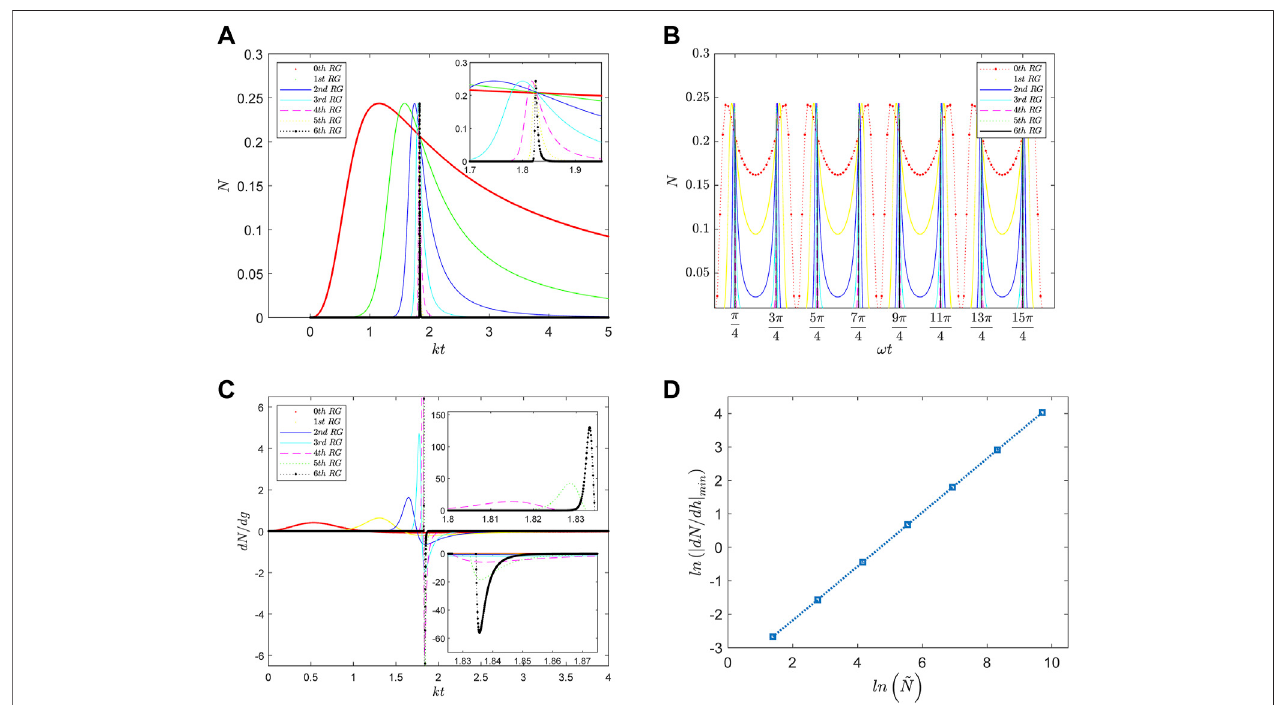
FIGURE 4 | (A) The evolution of negativity of the 2D model versus kt with B 3 ( t ), and (B) that versus ω t with B 4 ( t ) in terms of QRG iterations. (C) The evolution of fi rst derivative of N in terms of QRG iterations with B 3 ( t ). The upper and lower insets show the maximum and minimum of dN / dg at the critical point respectively. (D) The scaling behavior of ln(| dN / dg | min ) with respect to the system size ln ( ~ N )